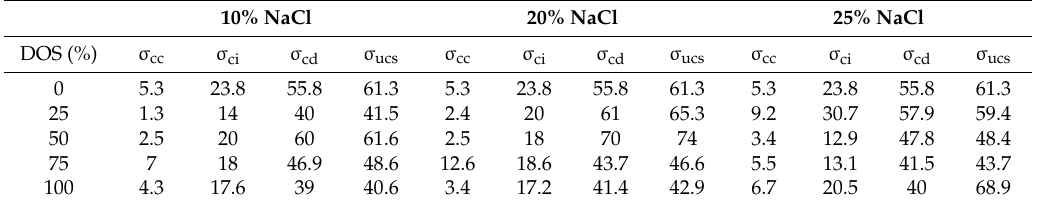
Table 3. Stress threshold value for dry and NaCl-saturated specimens.